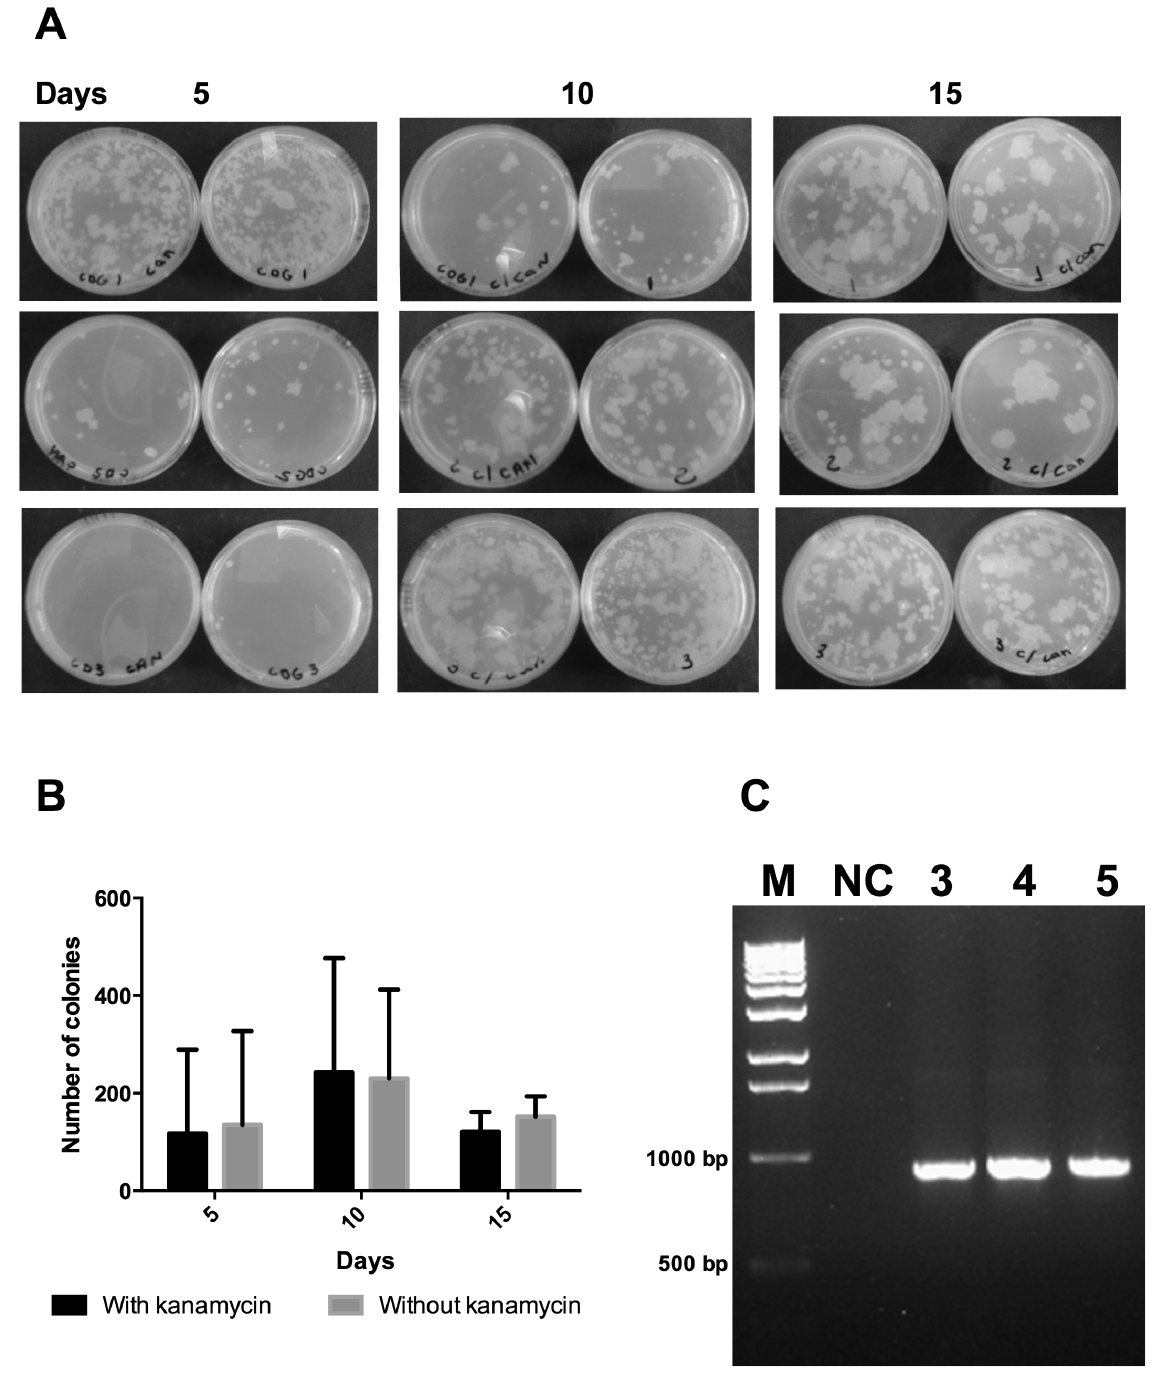
Figure 2. Stability of rBCG-CMX invivo . (A) Images of plates showing the mycobacterial growth of rBCG-CMX recovered from the dorsal region of mice 5, 10 and 15 days after subcutaneous immunization, and plated on media with kanamycin (kan) or without (W/o). (B) CFU counts recovered at different time points from the dorsal region of mice after immunization. (C) CMX gene detection by PCR for three isolated colonies from plates W/o kanamycin (Lanes 3–5). Lanes 1: M: molecular weight marker; 2: Negative control: NC: water.